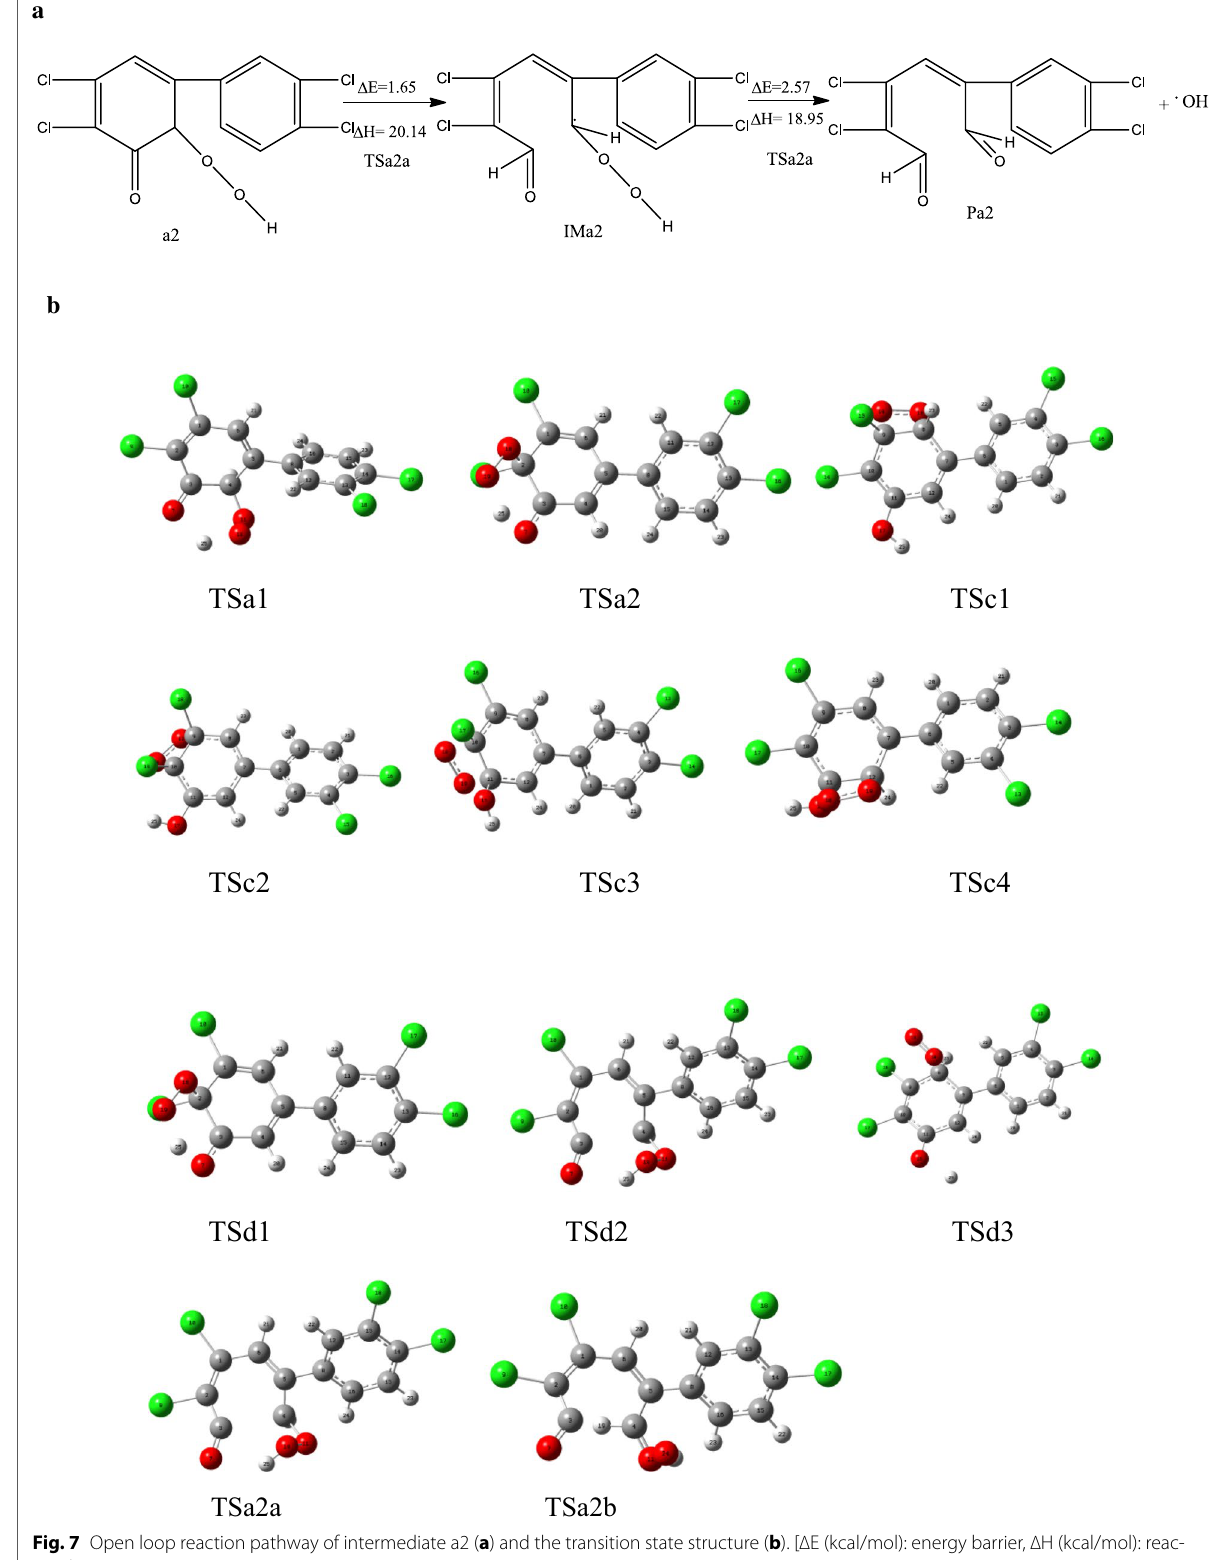
Fig. 7 Open loop reaction pathway of intermediate a2 ( a ) and the transition state structure ( b ). [∆E (kcal/mol): energy barrier, ∆H (kcal/mol): reac‑ tion